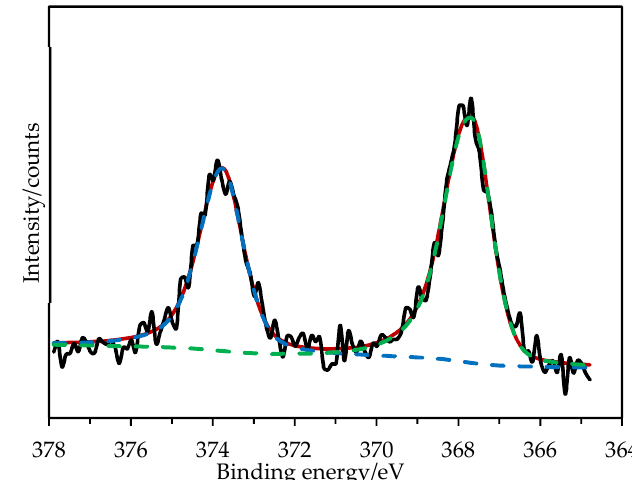
Figure 3. Narrow XPS Ag 3 d profile of Ti surface subjected to NaOH-Ca + Sr-heat-Sr + 1 mM Ag (pH = 4). Red solid line: composite line of blue and green dot lines, Blue dot line: deconvolution line of Ag 3 d 3/2 , Green dot line: deconvolution line of Ag 3 d 5/2 .